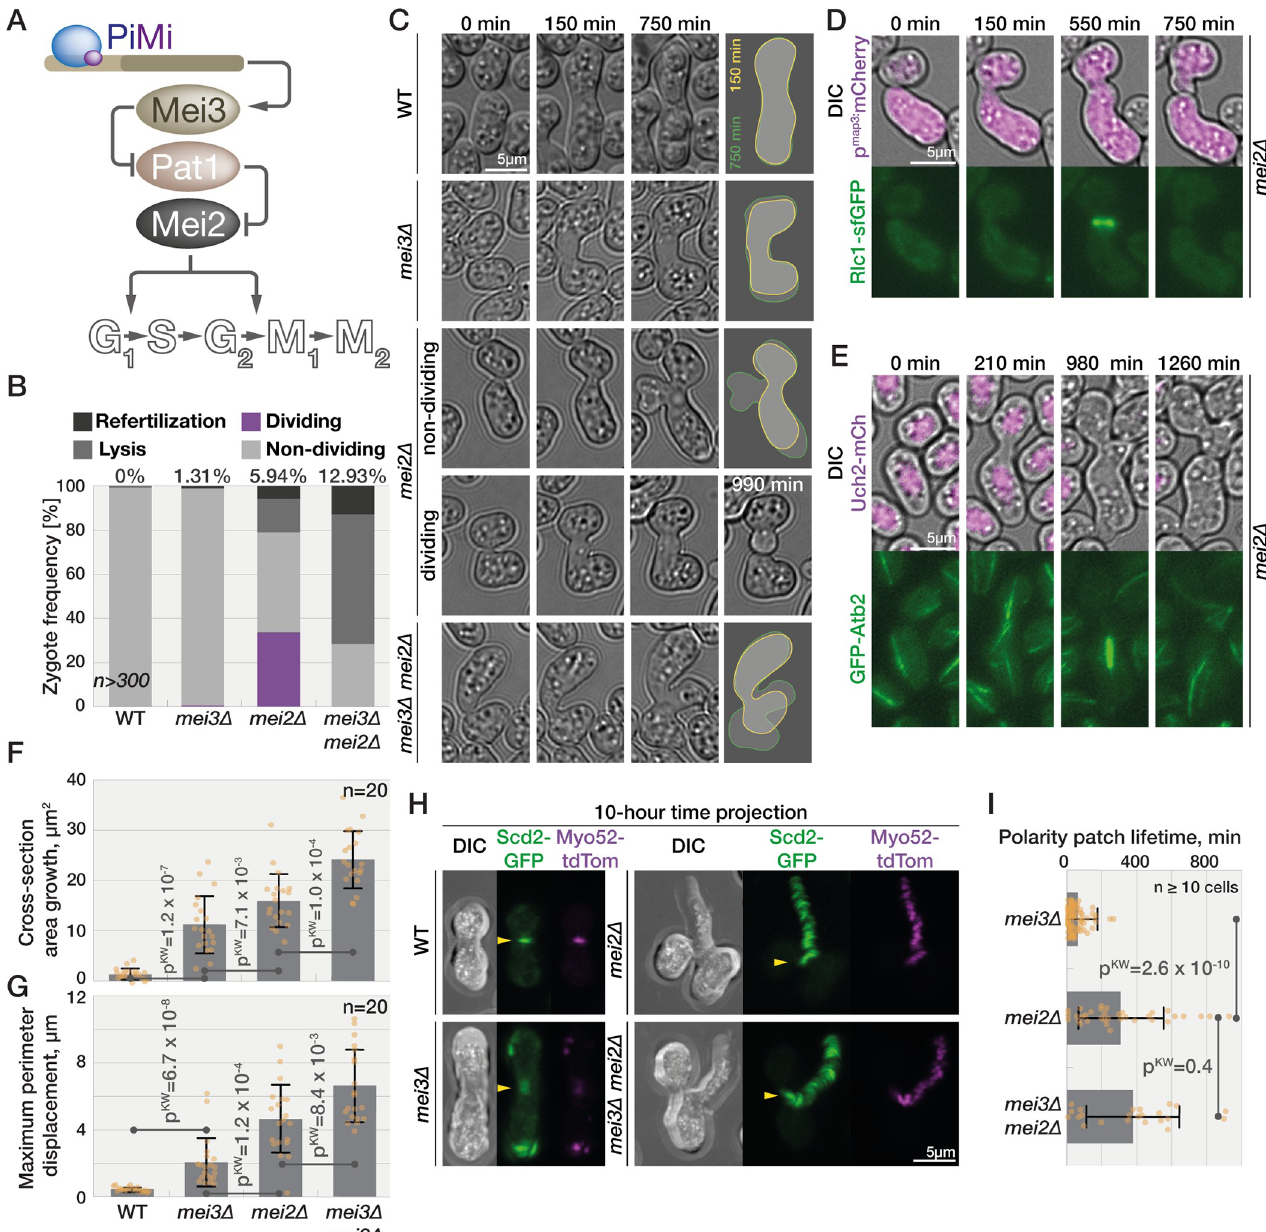
Fig 1. Meiotic signaling mutants show distinct phenotypes. (A) Schematic representation of meiotic signaling at the start of this study. (B) Quantification of phenotypes observed by long-term DIC imaging of zygotes. Numbers at the top report frequency of refertilization. (C) DIC images of cells prior to partner fusion (0 minute), at the time zygotes complete concave neck expansion (150 minutes; yellow outline in right panel) and 10 hours later (750 minutes; green outline). A fraction of mei2 Δ zygotes divides (here at 990 minutes). (D) Myosin light-chain Rlc1-sfGFP (bottom panel) in mei2 Δ cells expressing mCherry from P-cell-specific p map3 promoter (top panel, magenta overlaid with DIC) from prefusion (time 0) to zygote septation. (E) GFP- α -tubulin (bottom panel) in mei2 Δ cells also expressing nuclear marker Uch2 fused to mCherry (top panel, magenta overlaid with DIC). Note the cell division after the zygote forms a microtubule spindle. (F and G) Area increase (F) and maximum perimeter displacement (G) of zygotes observed by time-lapse imaging during 10 hours after neck expansion measured from outlines as shown in (C). Dots show individual measurements, bars mean values, and error bars standard deviation. p -Values for indicated comparisons were obtained from the Kruskal–Wallis test. (H) Projection of 60 time points during 10 hours from the time of neck expansion of polarity and growth markers Scd2-GFP (green) and Myo52-tdTomato (magenta). The arrowheads point to the signal at the neck. Both proteins are restricted to the neck in wild-type cells. In mei2 Δ and mei3 Δ mei2 Δ zygotes, both markers continuously trail the growth projection, while mei3 Δ zygotes show a fluorescent signal appearing at various cortical sites. See S1E Fig for individual time points. (I) Quantification of Myo52-tdTomato patch lifetime from data as (H) ( n � 10 cells). Data are presented as in (F). The data underlying this Figure may be found at https://doi.org/10.6084/m9.figshare.13274837.v1.